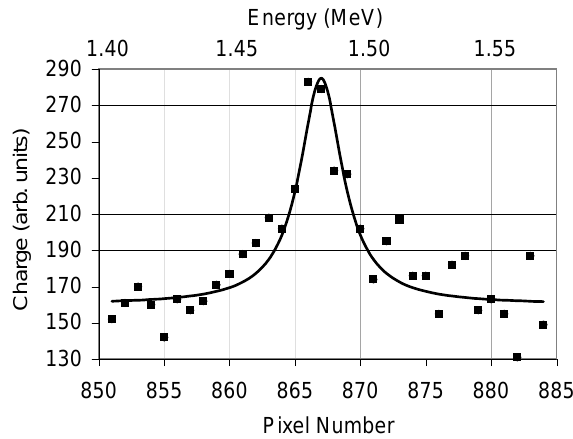
FIG. 14. Energy spread of the photoelectron beam as measured by the electron spectrometer. The energy spread is about